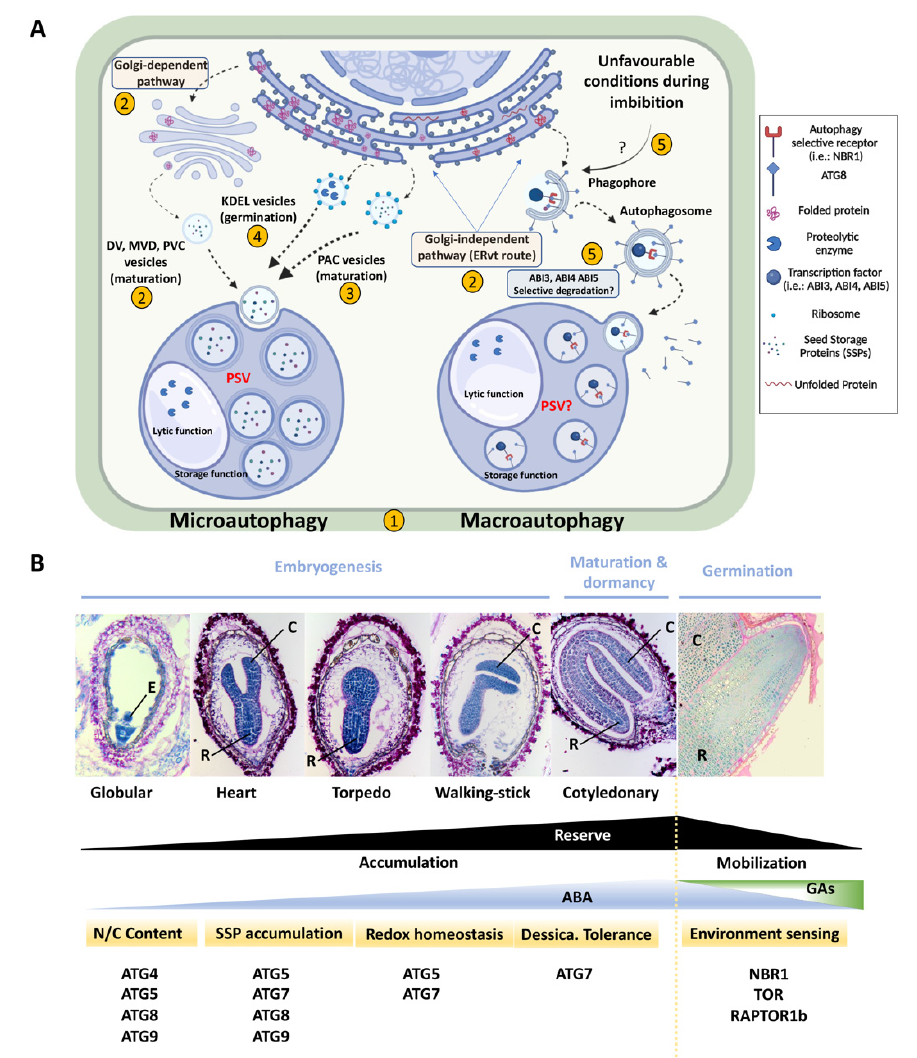
Figure 1. ( A ) Schematic representation of possible autophagy-like mechanisms in seeds. The Golgi- dependent pathway participates in the transport of DV, MVD, and PVC vesicles to the vacuole in a microautophagy-like mechanism during seed maturation. However, PAC and KDEL vesicles move from ER to PSV through the Golgi-independent route (also a microautophagy-like process). During seed imbibition, macroautophagy controls the expression of seed-specific transcription factors (ABI3, ABI4, and ABI5; ABA signaling) by a selective degradation mediated by ATG8 and the cargo receptor NBR1. Under unfavorable conditions, autophagy-selective degradation ceases, thus inhibiting seed germination. DV: Dense Vesicle; MVB: Multivesicular Vesicle Body; PAC: Pre-Accumulating Vesicle; PSV: Protein Storage Vacuole; PVC: Pre-Vacuolar Compartment. Picture created with BioRender.com (https://biorender.com/; accessed on 7 October 2022); numbers within yellow circles indicate sections in the manuscript where the particular process is described and references are provided. ( B ) Summary of the role of certain autophagic factors during seed development. Images illustrate a dicotyledonous seed from the globular stage during embryogenesis to germination. Sections are stained with naphthol blue-black (proteins in blue) and periodic acid plus Schiff’s reagent (insoluble polysaccharides in pink; R.I-F. contribution). ABA, GAs, and reserve levels are shown throughout seed development. ATG factors described as relevant in several aspects of seed development are indicated. C: Cotyledon; E: Embryo; R: Radicle. Mechanisms depicted in ( A , B ) are mainly taken from [10,27–33], and summarize all the content included in this mini-review.